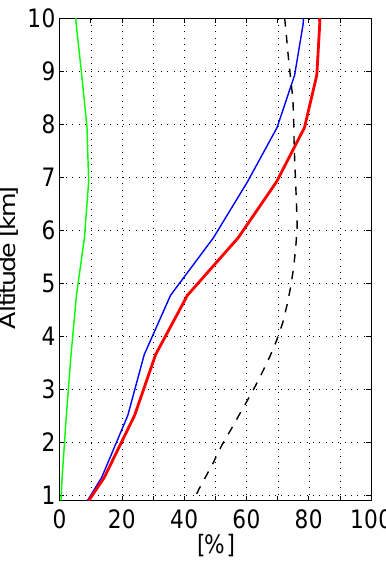
Fig. 8. Average error of the retrieval using 4h averaged spectra from 2007–2010. The error statistics contain the total error (red), which consists of observation error (green) and smoothing error (blue). The black dashed line in the right plot indicates the natural variabil- ity of water vapour.